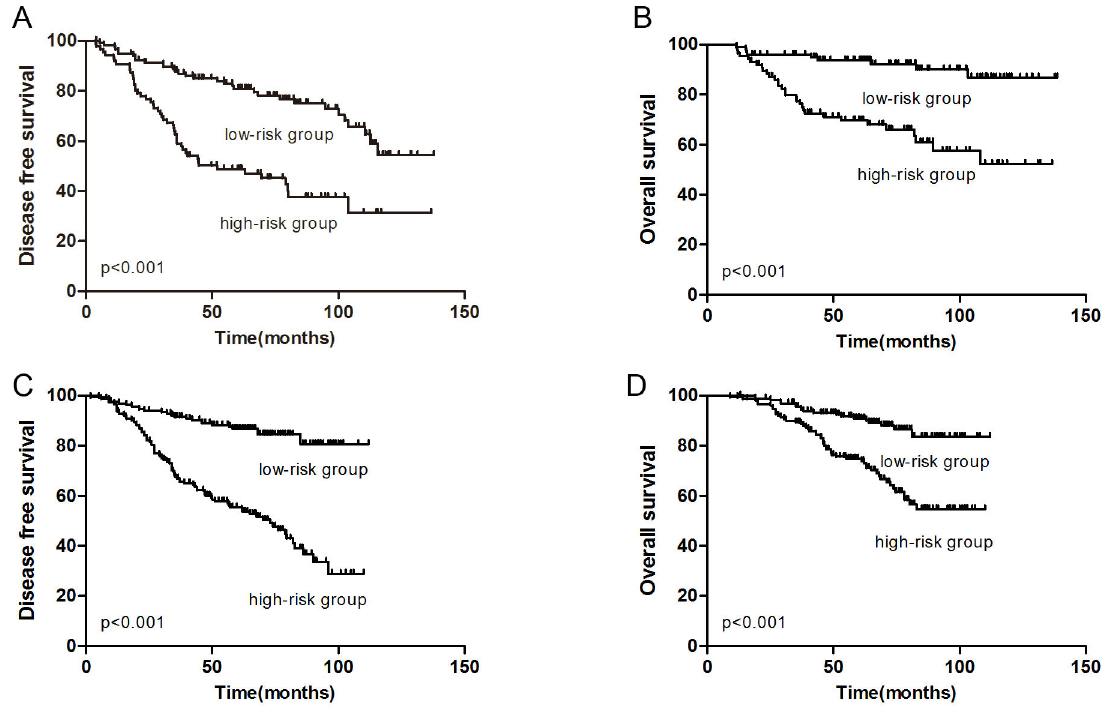
Figure 1. Kaplan-Meier curves for DFS (A) and OS (B) of TNBC patients in the training set according to the prognostic model. Kaplan-Meier curves for DFS (C) and OS (D) in the validation set.